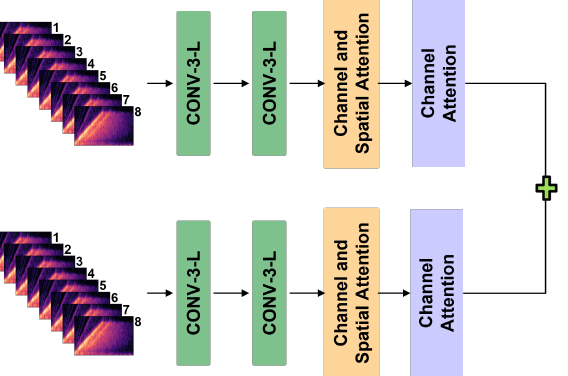
Figure 6. Each encoder consisted of two convolutional layers, CBAM and